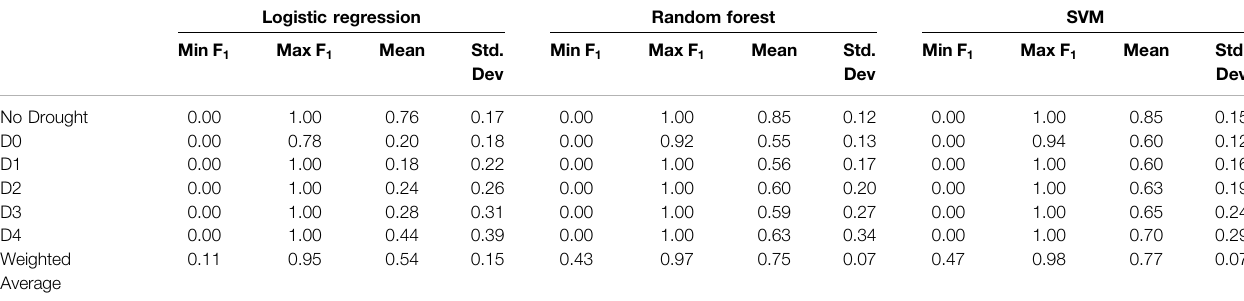
TABLE 4 | Descriptive statistics of the models performances using Group 1 input features over the entire domain. Logistic regression Random